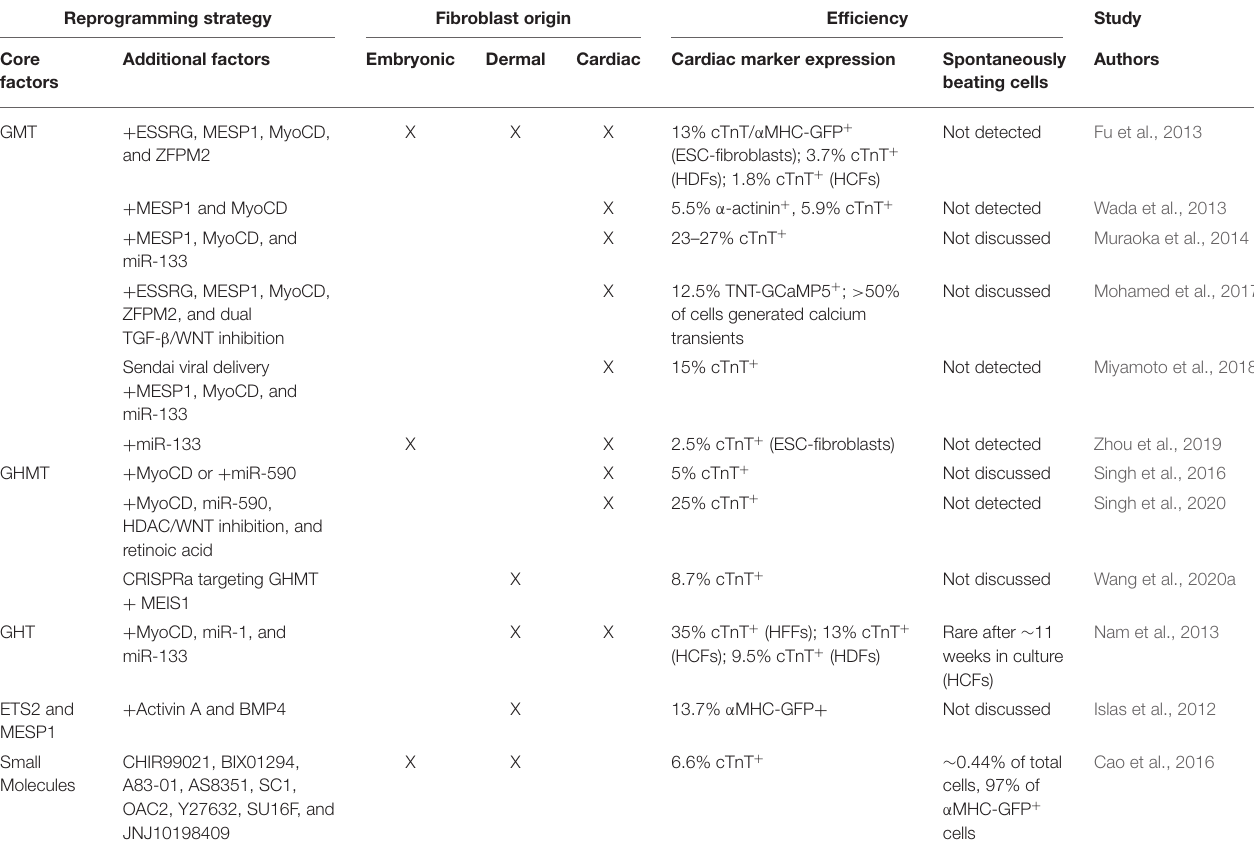
TABLE 4 | Reprogramming efficiencies in human